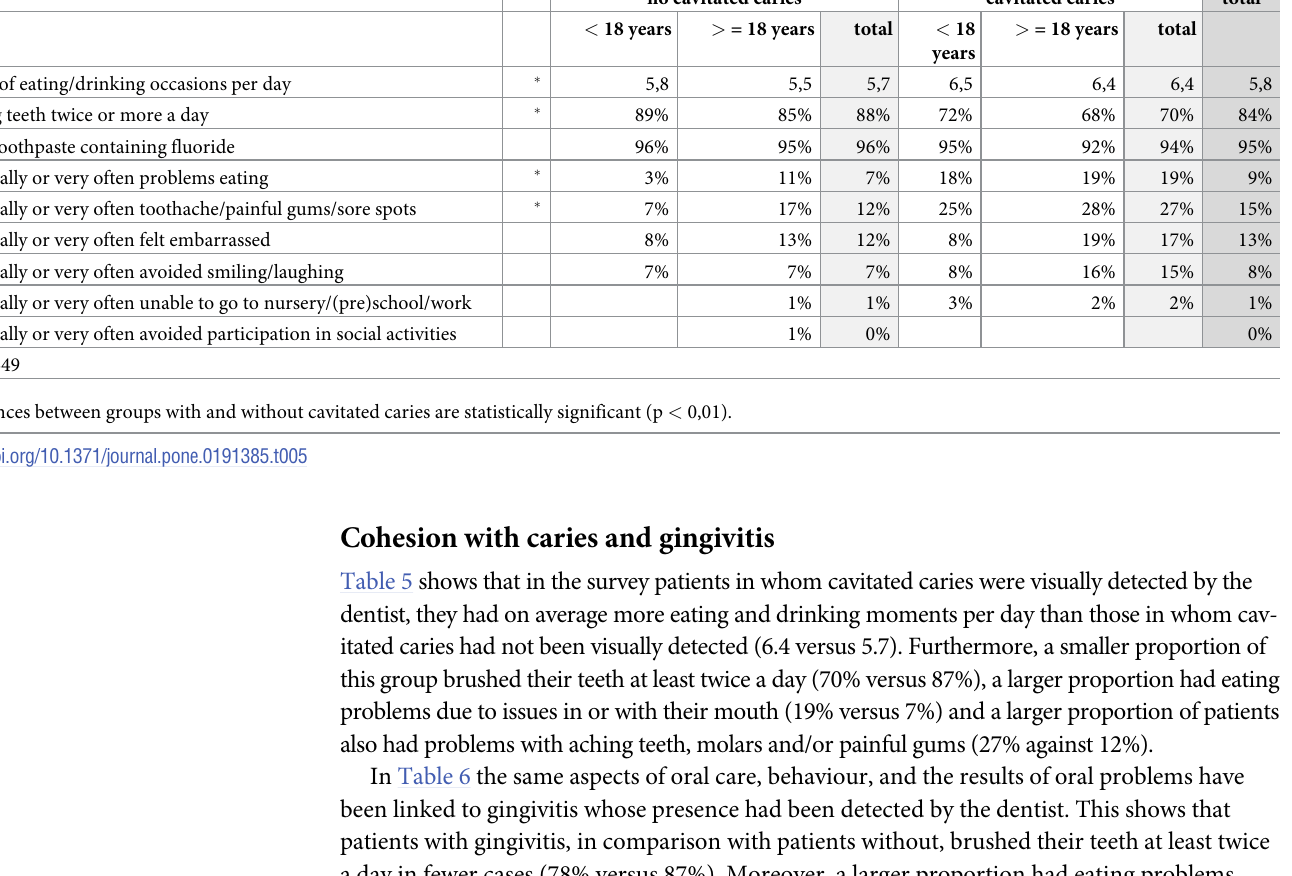
Table 6. Aspects of oral self-care and oral heath related quality of life in cohesion with the presence of gingivitis.